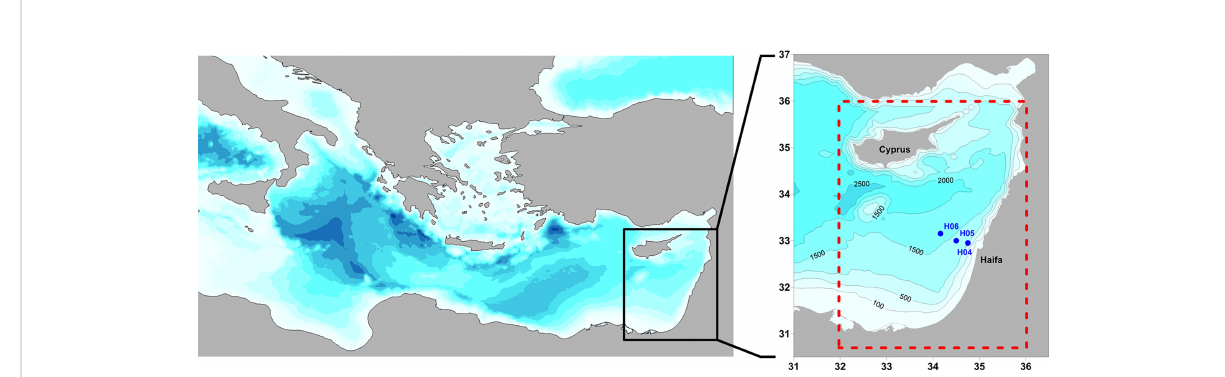
FIGURE 1 Map of hydrographic stations visited during the IOLR Haifa Section deep stations (blue dots, performed biannually). Station H05 was additionally visited in 10 cruises. Domain of CMEMS physical reanalysis used for MLD, and AW volume estimate is marked by the dotted red rectangle. IOLR, Israel Oceanographic and Limnological Research Institute; CMEMS, Copernicus Monitoring Environment Marine Service; MLD, mixed layer depth; AW, Atlantic